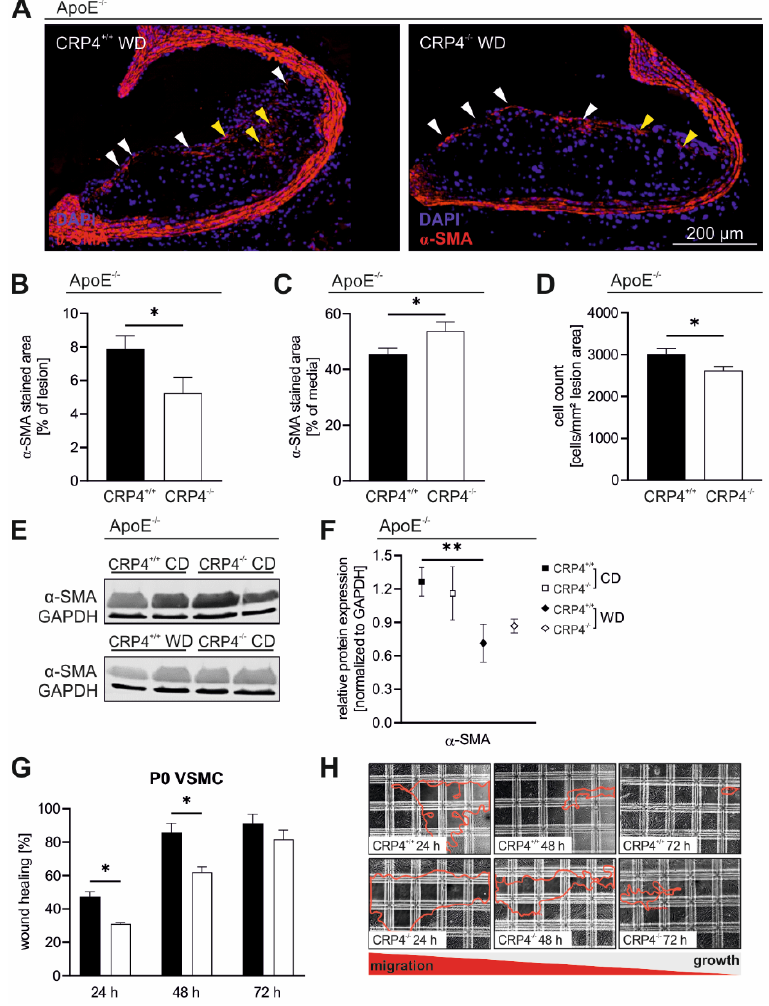
Figure 3. Lower α -SMA levels in CRP4-deficient atherosclerotic lesions . ( A ) Immunofluorescence staining using α -SMA-specific antibodies (red) and Hoechst (blue) of atherosclerotic plaques from ApoE − / − /CRP4 +/+ versus ApoE − / − /CRP4 − / − mice. ( B ) In the absence of CRP4, α -SMA-abundance in the lesion (yellow arrowheads) and cap (white arrowheads) area was significantly decreased, while ( C ) in the media, the α -SMA expression was exactly the opposite in CRP-proficient versus -deficient vessels. ( D ) The number of total cells was estimated by counting the intra-plaque nuclei. The number of nuclei was lower in the absence of CRP4; n = 8–9 per genotype, * p < 0.05 and two-tailed Student’s t -test. ( E , F ) Western blot analyses confirmed the decrease of α -SMA in the aorta of WD-fed versus CD-fed groups, although no genotype-specific difference was apparent. GAPDH was used as the loading control for the blots, at n = 4 per genotype with each n representing a pool of two aorta. The red line in ( H ) highlights the area that remained uncovered by the VSMCs at the time points indicated; ** p < 0.01 and two-tailed Student’s t -test. ( G ) P0 VSMCs (P0), resembling cells that